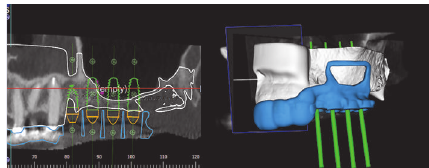
Figure 6: The position of the implants is preplanned on the CBCT scan. A surgical guide is designed that includes also the frame of the sinus antrostomy designed according to the low window principles.